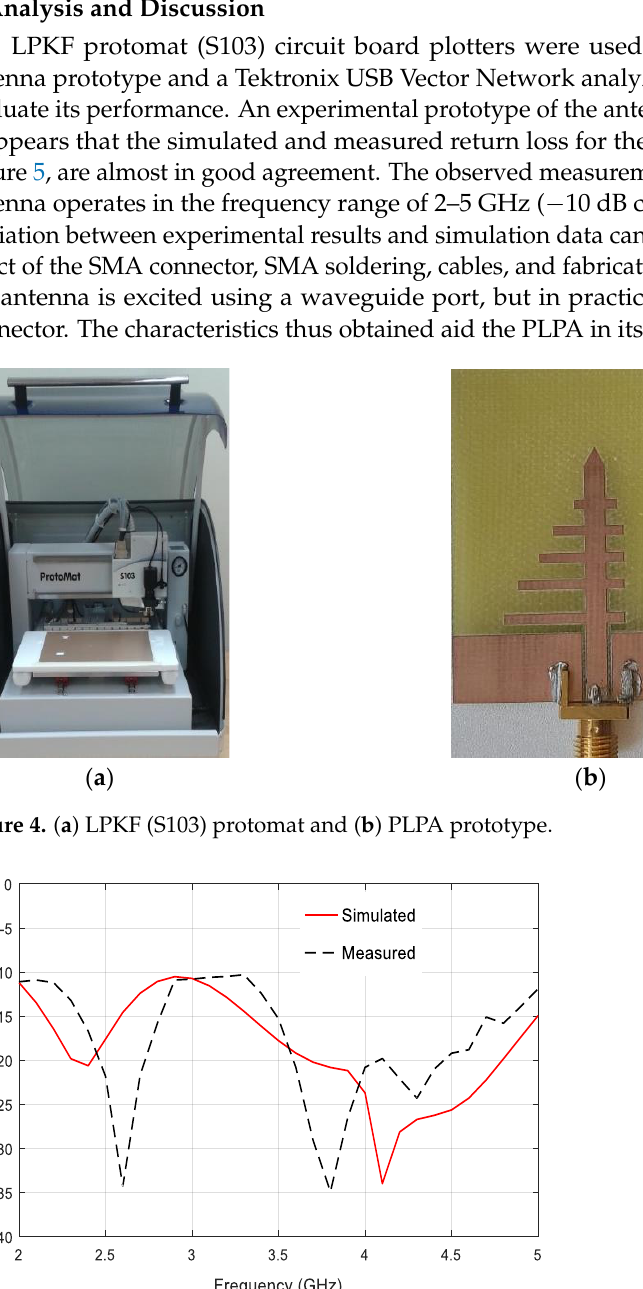
Figure 3. Return loss variation versus frequency for different values of w 6.